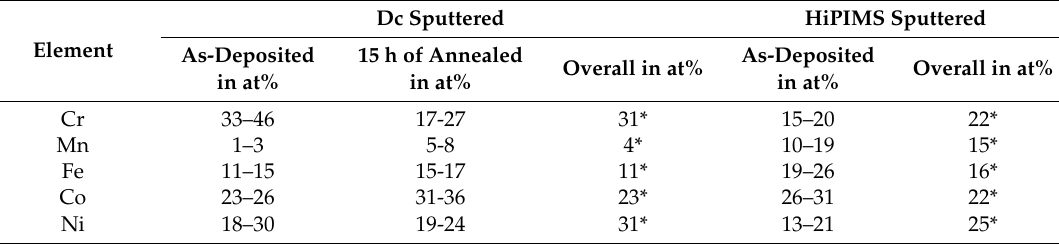
Table 1. Composition range of dc sputtered (as-deposited and 15 h annealed) and HiPIMS sputtered NPs transferred from the NP IL suspension onto a carbon-coated gold grid. Comparison of the STEM-EDS analysis with the overall composition of the sputtered NPs within the IL measured with ICP-MS (*) in at%. Dc